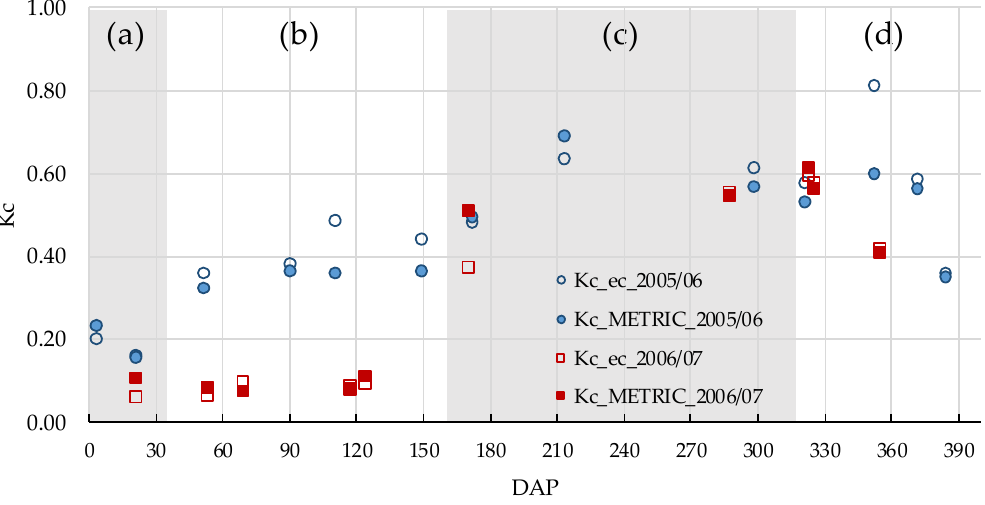
Figure 5. Daily values of crop coefficient estimated by METRIC (Kc _METRIC ) and observed by the eddy covariance system (Kc _ec ) in the June 2005 and July 2006 sugarcane cycles at USR site. Shaded areas separate the phenological stages of ( a ) germination, ( b ) tillering, ( c ) growth, and ( d ) maturation. DAP = days after planting.